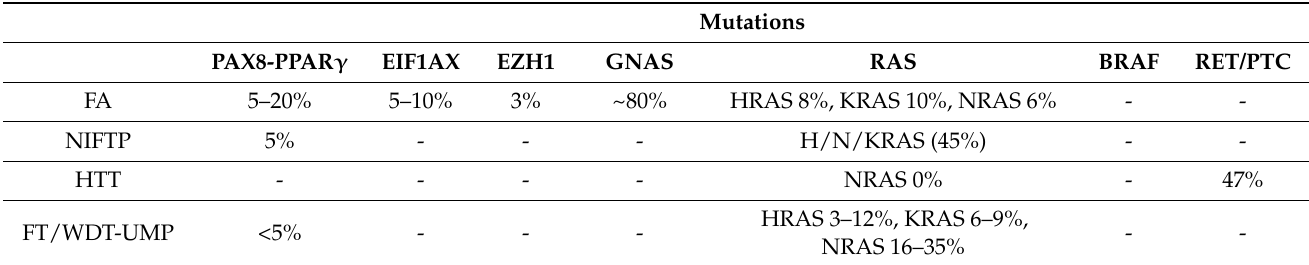
Table 1. Histological and molecular heterogeneity in FA and follicular-patterned borderline lesions (H,K,N isoforms of RAS gene